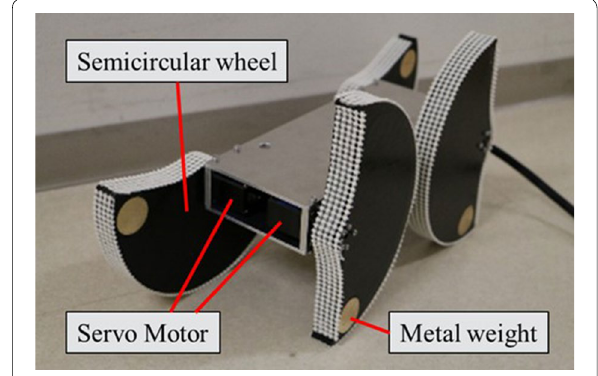
Fig. 4 Semicircular wheels robot